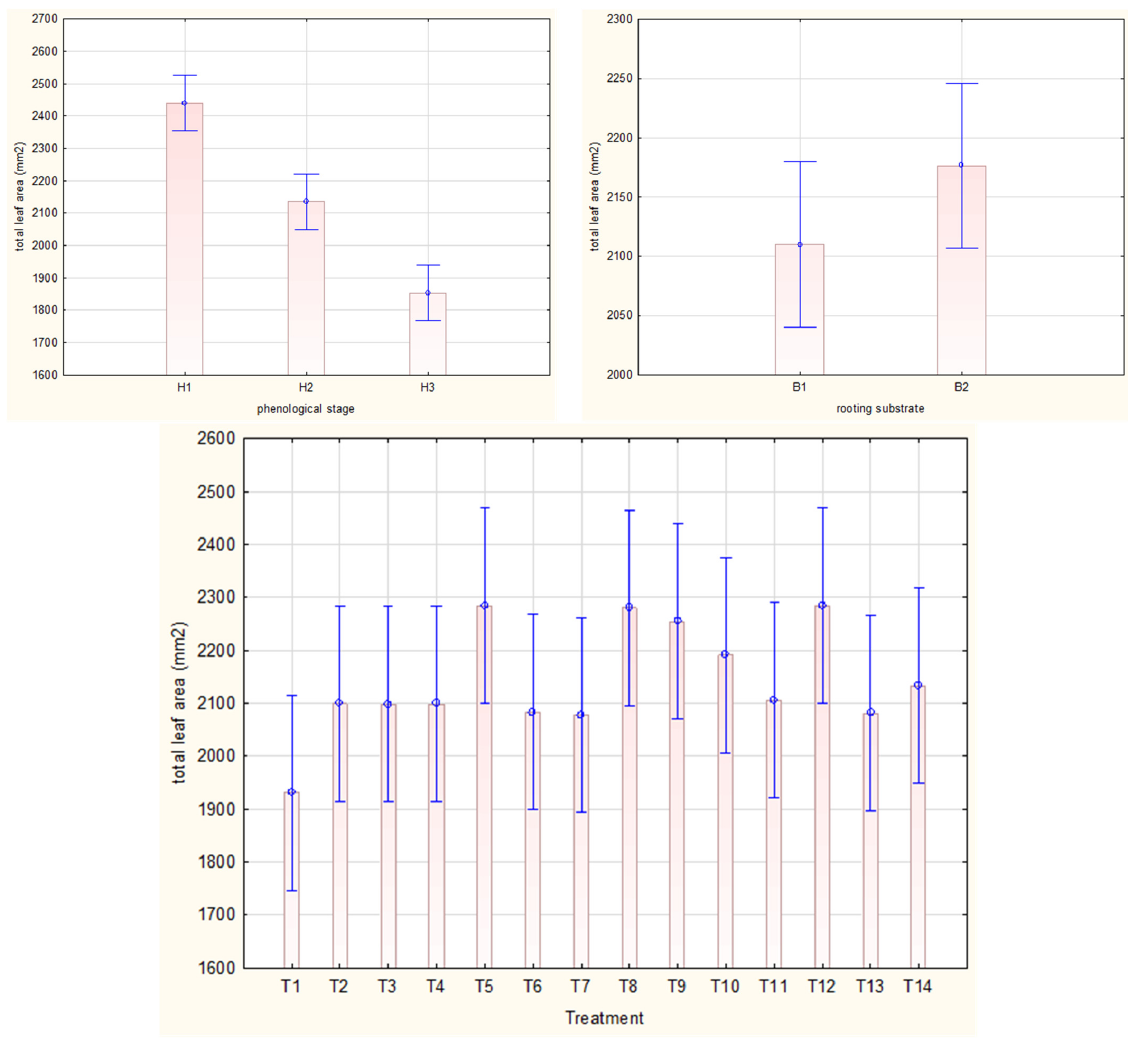
Figure 7. Total leaf area (mm 2 ) in Rosa ‘Hurdal’ cuttings prepared from three phenological stages (H1–H3) of shoots and rooted in two rooting substrates after treatment by rooting